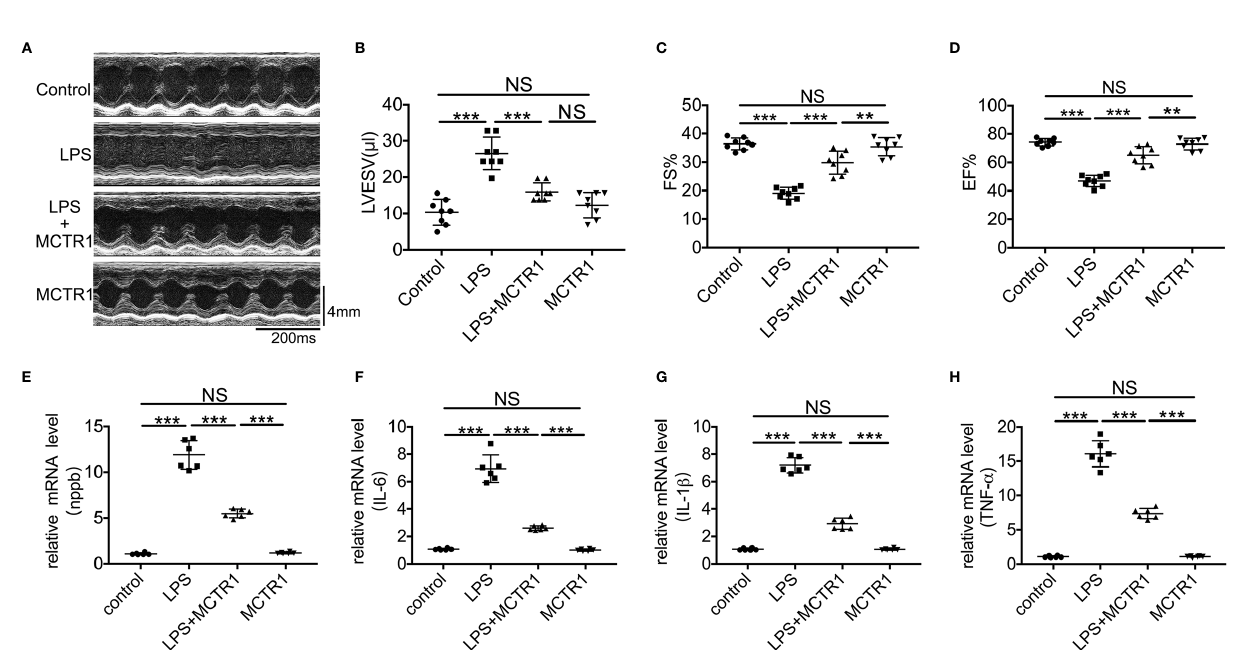
FIGURE 1 | The effect of MCTR1 on cardiac function in LPS-challenged mice. (A) Representative M-mode echocardiographic recordings. (B – D) Left ventricular end-systolic volume (LVESV), fractional shortening (FS), and ejection fraction (EF) were analyzed (n = 8). (E – H) Nppb, Tnf- a , IL-1 b , and IL-6 mRNA expressions were examined by quantitative PCR in the hearts (n = 6). Data are shown as means ± SD. ** P < 0.01; *** P < 0.001; NS, not signi fi